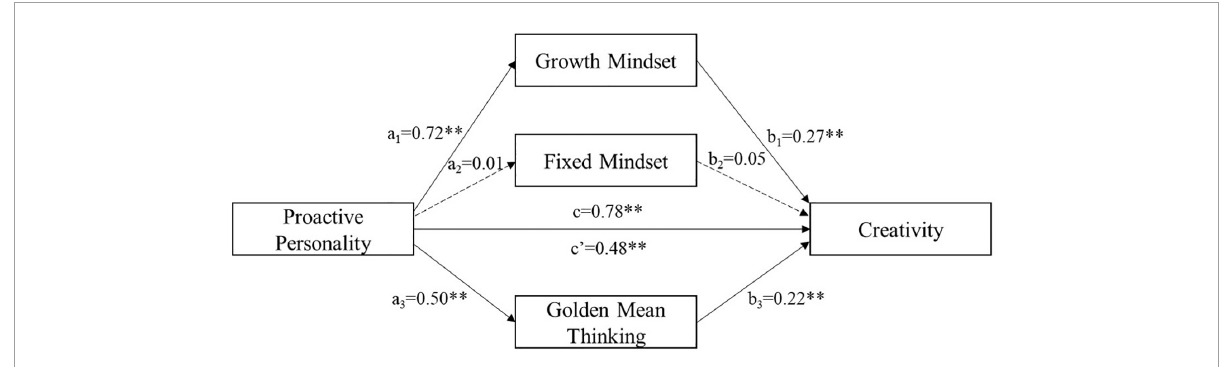
FIGURE2 Mediation model linking proactive personality and creativity through growth mindset, fixed mindset and golden mean